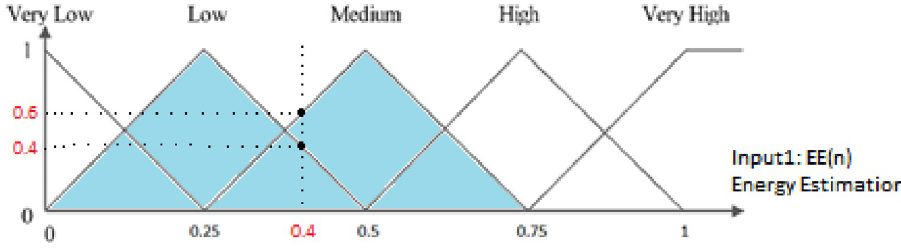
Fig 6. A numerical example of the estimated energy value of a node and its fuzzy outcome.